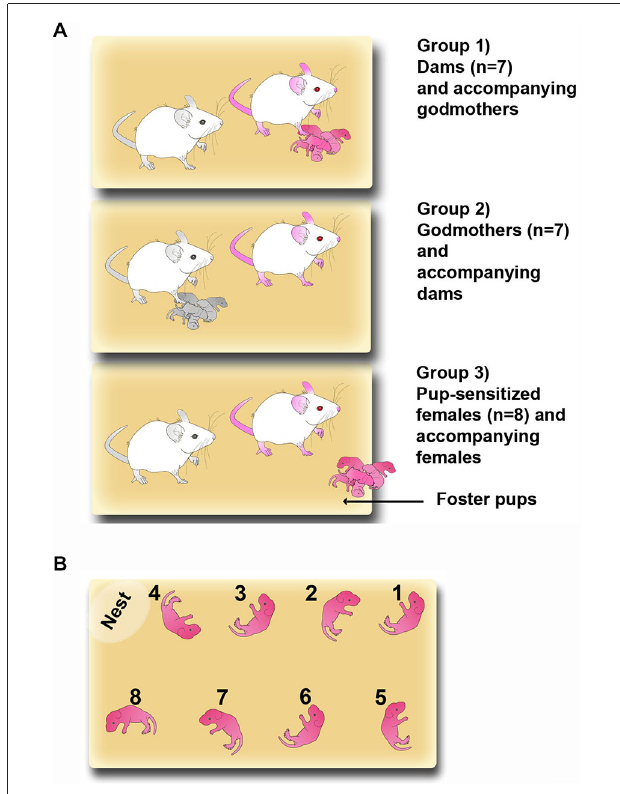
FIGURE 1 | Maternal sensitization models. (A) Sketch of the three experimental groups: Group (1) dams and accompanying godmothers; Group (2) godmothers and accompanying dams; and Group (3) pup-sensitized females and accompanying virgin females. Pup-sensitized females were isolated and exposed to pups 2 h daily. Pink-colored drawings represent the experimental females and black and white drawings are the accompanying females. (B) Sketch showing the detailed procedure for placing pups in the pup-retrieval